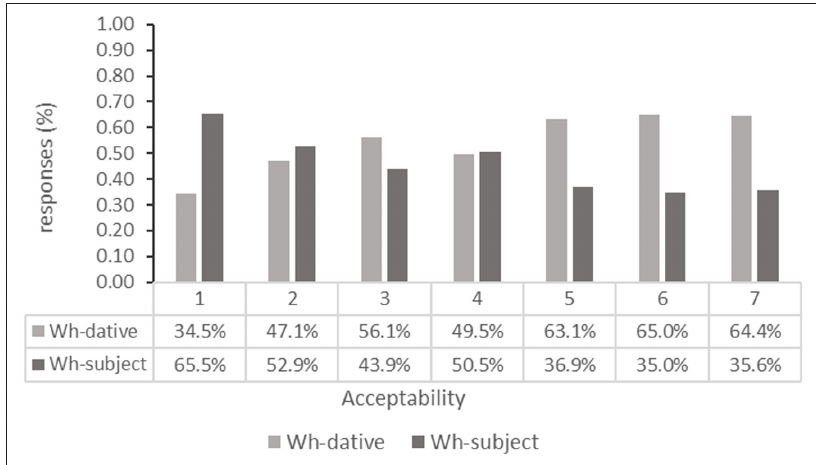
Figure 4: Distribution of acceptability ratings on a 7-point Likert scale in the Study 1 (1 = ‘not acceptable’; ‘7 = totally